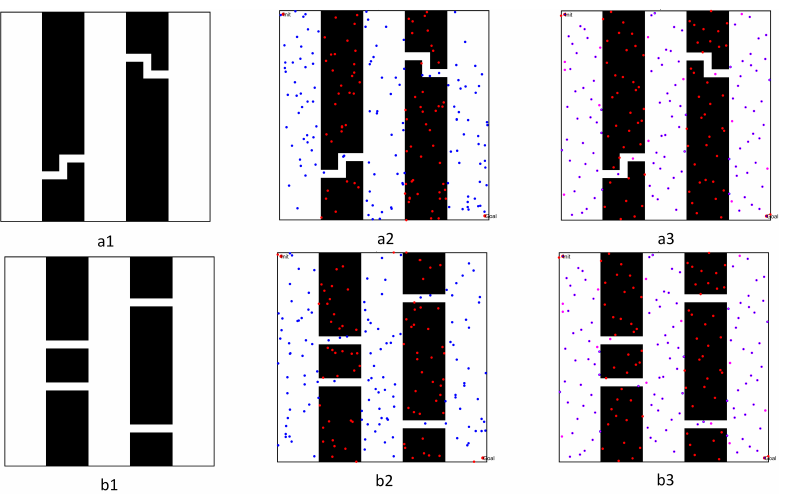
Figure 24. The workspace and sampling results for environments with multiple narrow channels: ( a1 , b1 ) The workspaces of different environments; ( a2 , b2 ) sampling points based on the random sampling method; and ( a3 , b3 ) sampling points based on the quasi-random sampling method.